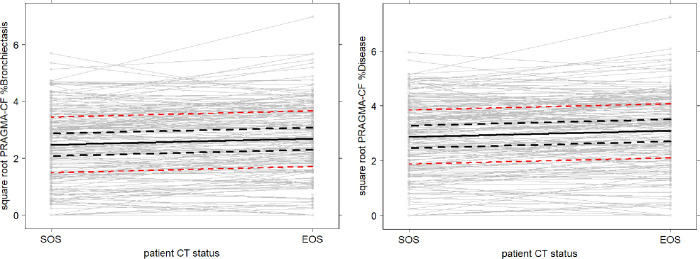
Change of PRAGMA-CF %BE (A) and %Disease (B) from EOS to SOS per patient. These plots show the change in PRAGMA-CF %BE (A) and PRAGMA-CF %Disease (B) from start of study (SOS) to end of study (EOS). Grey open circles represent the measurements of individual patients and the grey lines are plotted between the measurements of a single patient at SOS and EOS time-point. Black solid line represents the change obtained by the linear mixed model for patients with ataluren and tobramycin treatment. Note that for other subgroups the lines would not be statistically different as there was no significant impact for any of the other investigated confounders. The dashed black lines represent the confidence interval, and the dashed red lines the prediction interval. Note that for PRAGMA-CF %Disease values are presented in the square root scale—which is the scale that was used to analyse the data as the errors for this subscore were not normal distributed. Furthermore, note that due to the large number of patients included in the figure the grey open circles might appear filled.